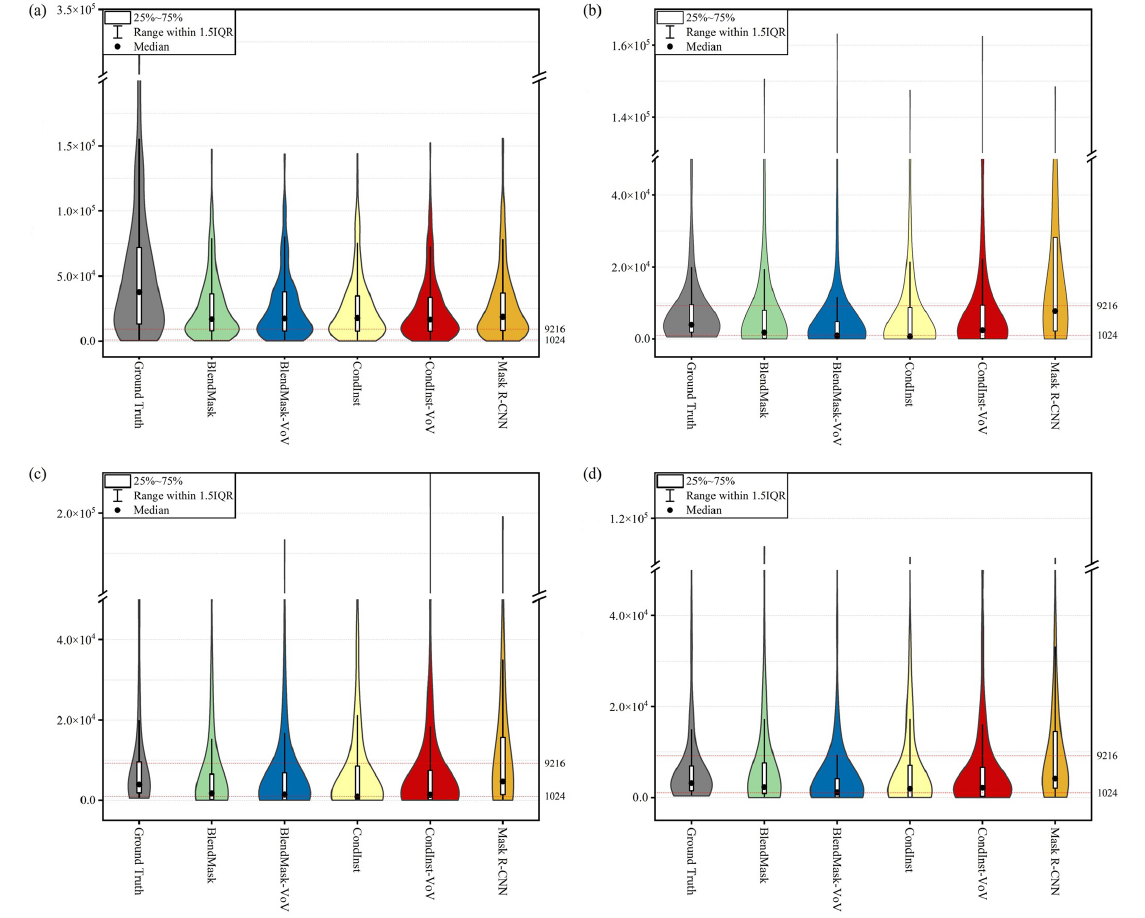
Figure 14. Statistical graph of object area in KOMMA dataset. The size of the violin plot in the same coordinate system positively correlates with the number of pixels. ( a ) Object area in the KOMMA dataset; ( b ) object area in the true-color image; ( c ) object area in the false-color image; ( d ) object area in the Tianditu